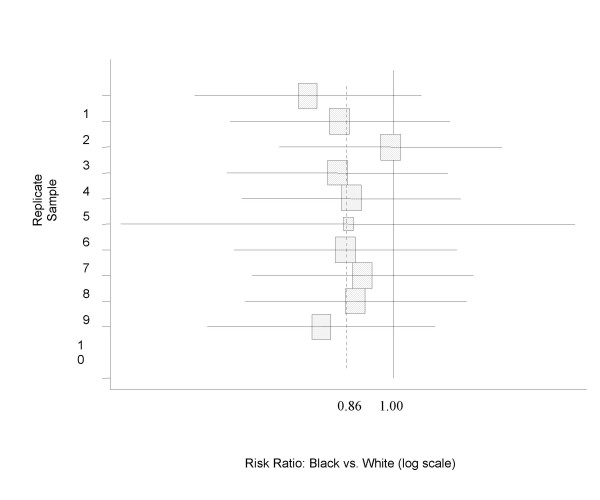
Results of regression analysis for race with the dependent variable use of guideline-concordant antibiotics. Forest plot demonstrating the results of the 10 individual conditional logistic regressions models for the dependent variable use of guideline-concordant antibiotics after adjusting for severity of illness using the PSI. The presented relative risk with 95% confidence intervals is for the independent variable race (dichotomized into black versus white).